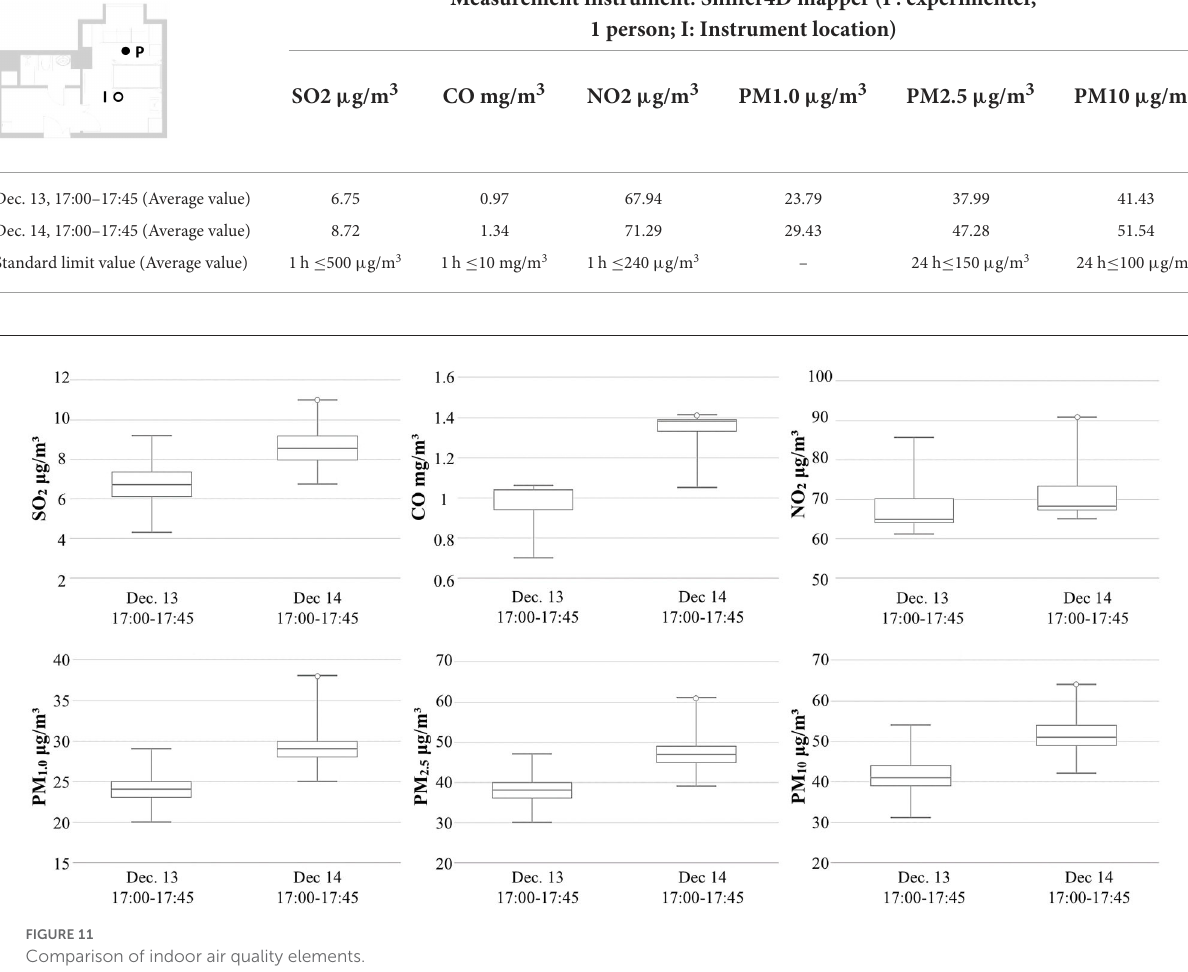
TABLE 4 Recorded values of indoor air quality elements. Measurement instrument: Sniffer4D mapper (P: experimenter,